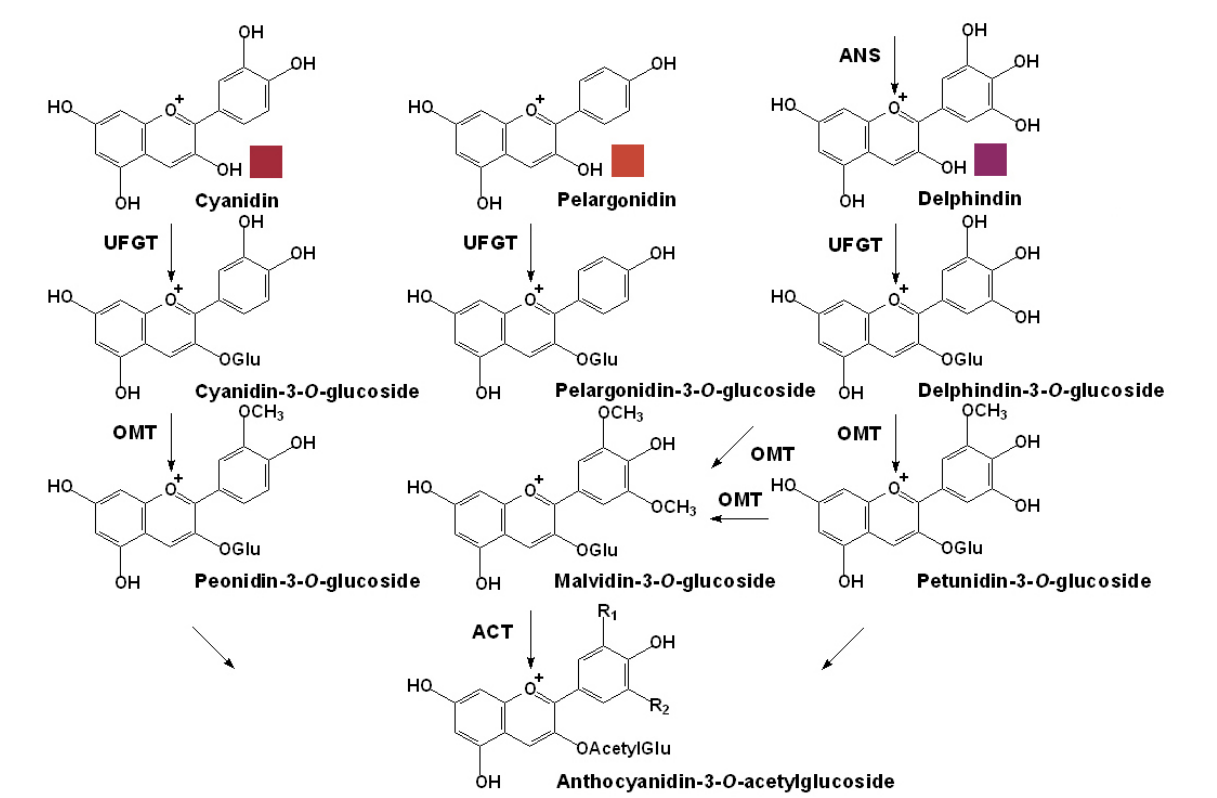
Figure 5. The specific pathway for the anthocyanin modification of free anthocyanidins in